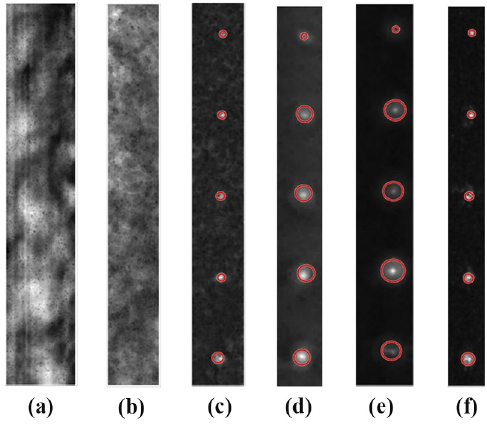
Figure 9. Sample A-41 side